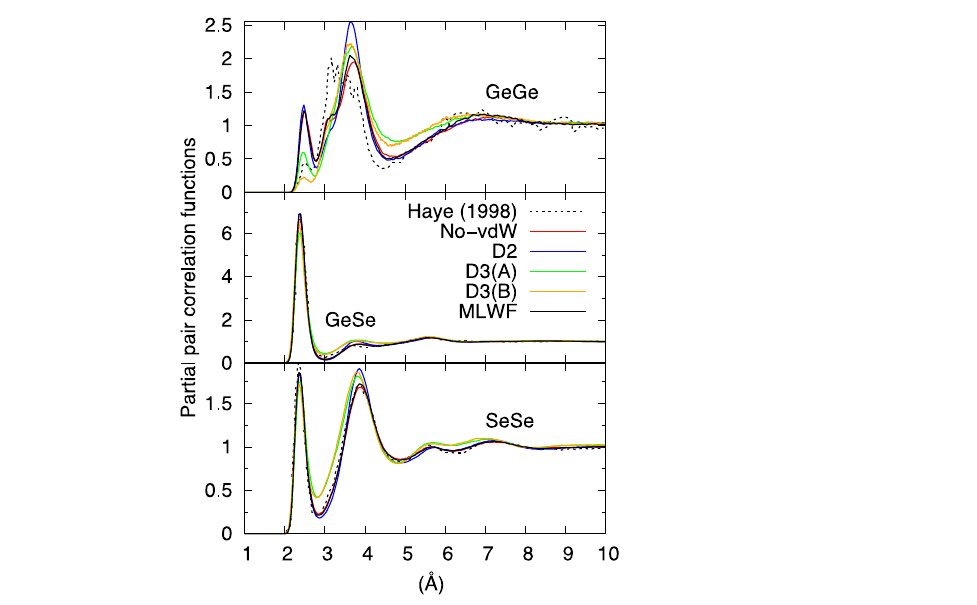
Figure 2. Calculated partial pair correlation functions for liquid GeSe 4 . Haye (1998) stands for Ref. [16]. Table 1. Coordination numbers of liquid GeSe 4 calculated with the various schemes for the dispersion forces detailed in the text. The values have been obtained by integrating the partial pair correlation functions up to the first minima.